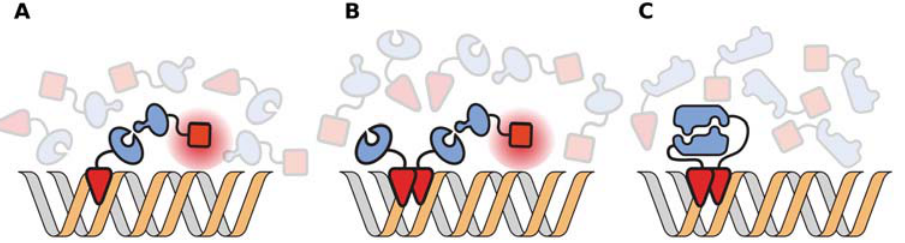
Figure 3. Shortcomings of the yeast two-hybrid assay. (A) The traditional view of the yeast two-hybrid assay. A bait protein is hybridized with the GAL4 binding domain which binds to the upstream activation sequence for galactose (UAS G ). A prey protein hybridized with the GAL4 activation domain interacts with the bait protein. The complex forms a functional transcriptional activator and the downstream reporter gene is expressed. (B) A more accurate view of yeast two-hybrid assay. The GAL4 binding domain actually binds to UAS G as a dimer. (C) If the GAL4 binding domain is hybridized to a self-interacting protein, self-interacting protein bait dimerizations would reduce the probability of bait-prey interactions.